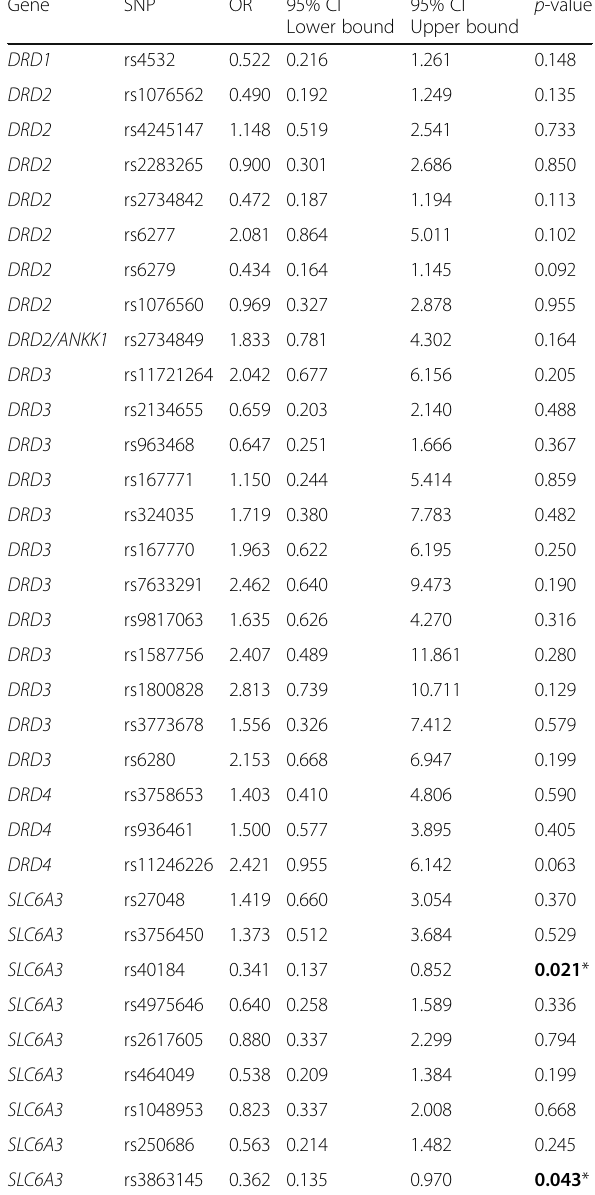
Table 5 Analysis of association between HPRL and the genetic polymorphisms in patients from risperidone/paliperidone group